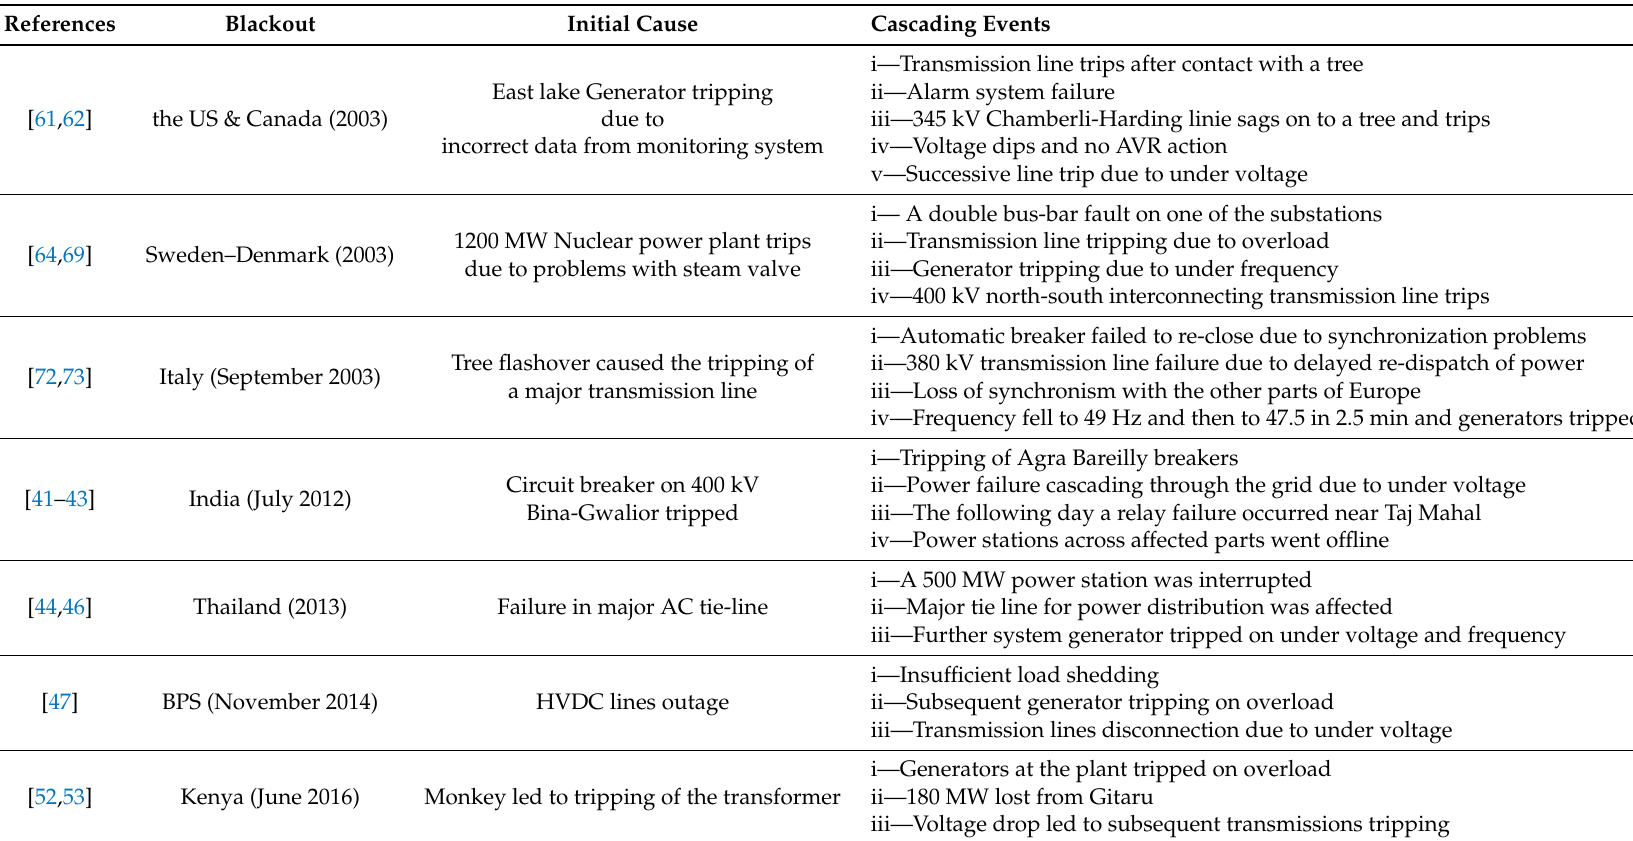
Table 8. An overview of the initial disturbances and the cascading events led to the major blackouts around the